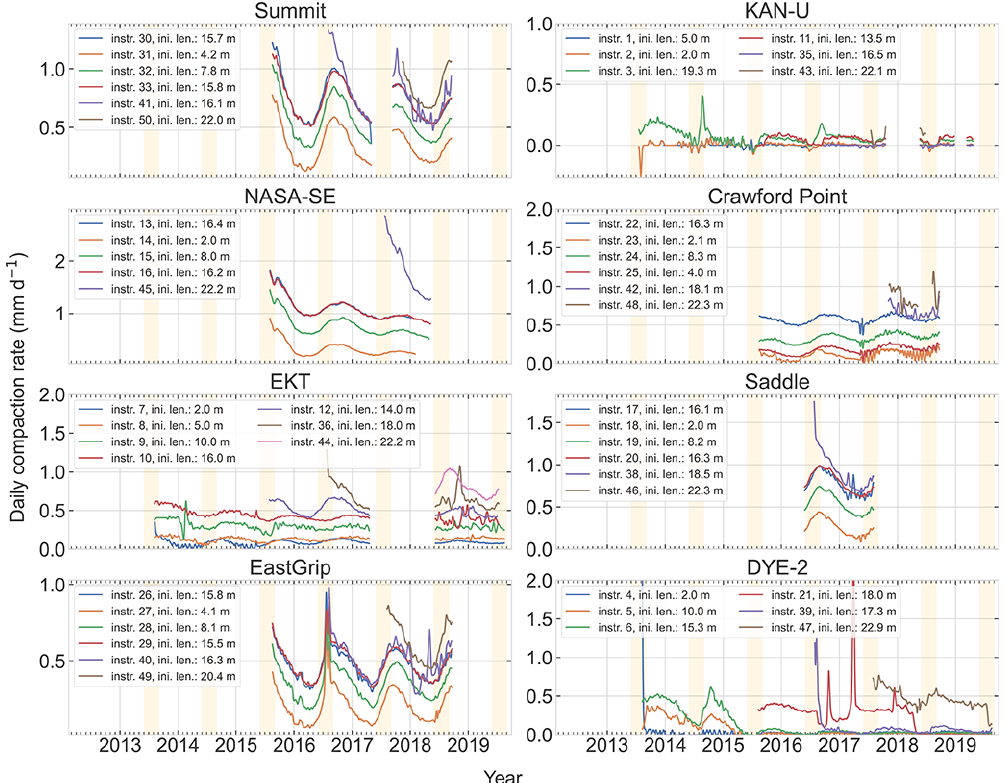
Figure 5. Smoothed daily compaction rates. The legend indicates the ID of each instrument as reported in Table 2 and the initial length of each borehole. June–July–August are highlighted in orange. Note the different y axes.